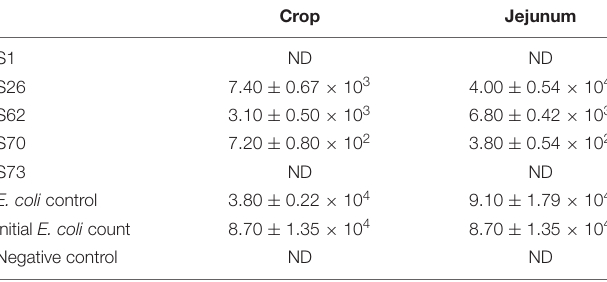
TABLE 2 | Survival of the E. coli model strain after 24 h incubation with lactic acid bacteria candidates in intestinal contents (CFU/g